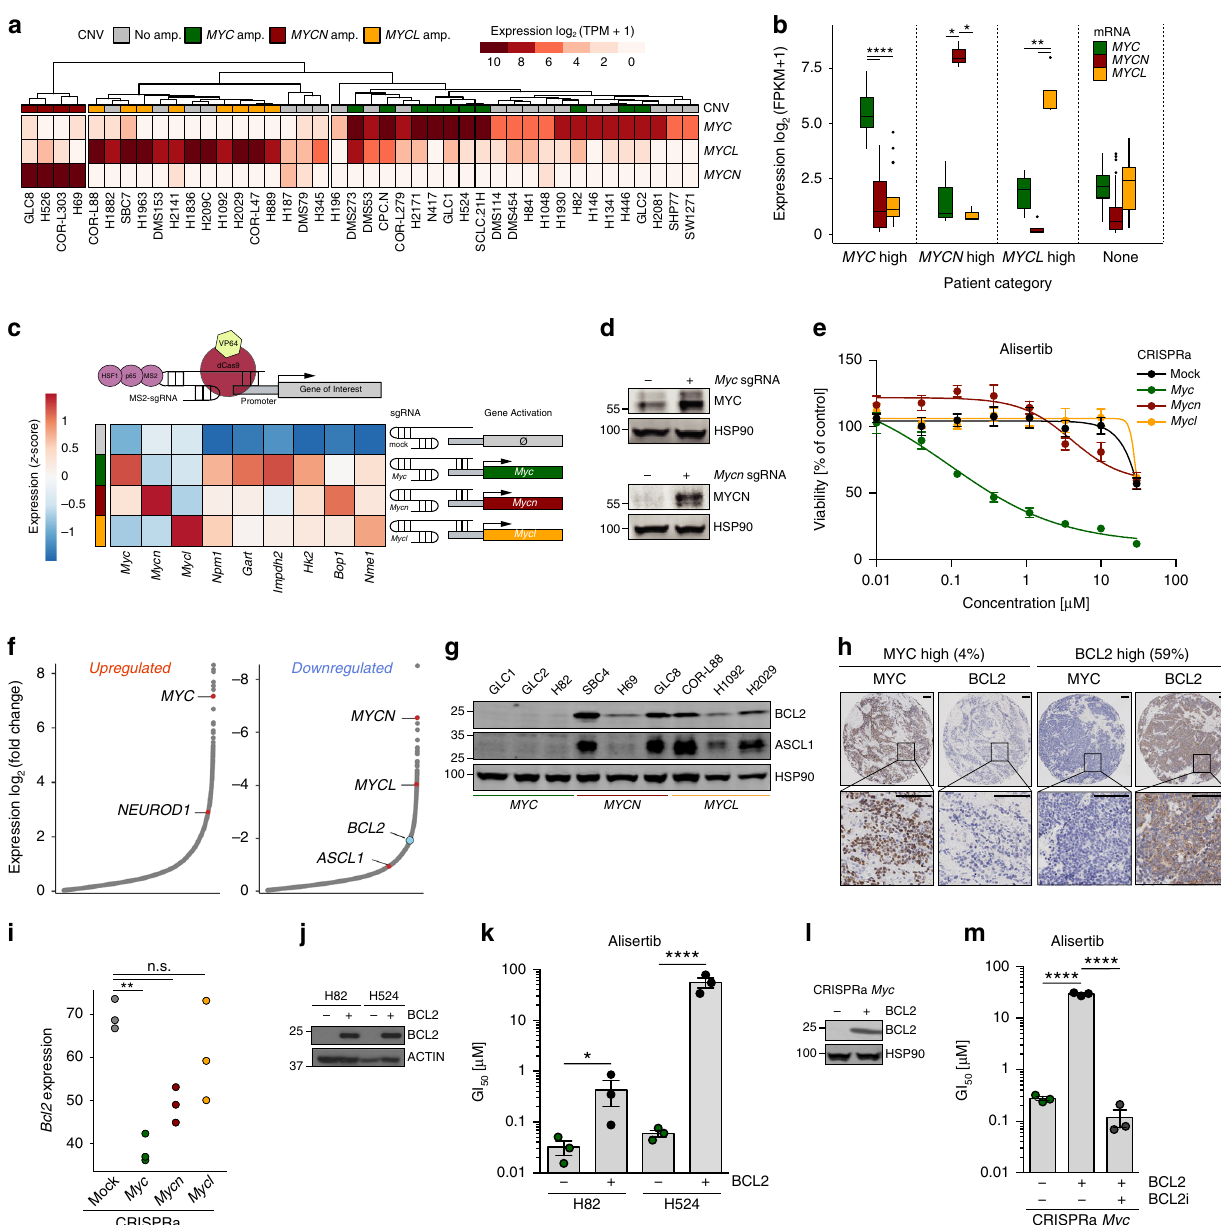
Fig. 1 MYC activation is associated with low BCL2 expression. a MYC paralog expression (TPM) and copy number variation (CNV) in human small cell lung cancer (SCLC) cell lines ( n = 42). b MYC paralog expression in SCLC patients. Center line (median), lower/upper box hinges (25th/75th percentile), whiskers extend to the most extreme value within 1.5× interquartile range (IQR) of the hinges. c CRISPRa system for transcriptional upregulation of Myc paralogs (top). Expression ( z -scores) of Myc paralogs and Myc target genes in CRISPRa cells (bottom). d Western blot showing MYC and MYCN in Myc- and Mycn -activated CRISPRa cells compared to mock control. HSP90 was used as a loading control. e Viability screening of Myc -activated CRISPRa cells treated with alisertib for 96 h ( n = 3). f Differentially upregulated and downregulated genes (sorted by log 2 fold-change) in human SCLC cell lines ( n = 42) with high MYC ( n = 22) vs. low MYC ( n = 20) expression. g Western blot of ASCL1 and BCL2 in MYC paralog-ampli fi ed human SCLC cell lines ( n = 9). HSP90 was used as a loading control. h Immunohistochemical staining of MYC and BCL2 in tumors of SCLC patients with high MYC (left) or high BCL2 (right) expression (percentage of patients in the cohort ( n = 49) with high BCL2 or MYC levels is indicated. Scale bar = 100 µ m). i Bcl2 expression (counts normalized to library size) in Myc paralog-activated CRISPRa cells. Benjamini – Hochberg-adjusted p values for Myc paralogs were obtained as contrasts of a global differential expression test. j Western blot showing BCL2 levels in MYC -ampli fi ed H82 and H524 cells ± BCL2 overexpression. HSP90 was used as a loading control. k GI 50 values of MYC -ampli fi ed H82 and H524 cells ± BCL2 overexpression treated with alisertib for 72 h ( n = 3). l Western blot of BCL2 in Myc -activated CRISPRa cells ± BCL2 overexpression. HSP90 was used as a loading control. m GI Myc -activated CRISPRa cells ± BCL2 50 values of overexpression treated with alisertib alone or in combination with 500 nM venetoclax (BCL2i; n = 3). Error bars indicate mean ± SEM. Two-tailed unpaired t tests, **** p < 0.0001, ** p < 0.01, * p < 0.05. Source data are provided as a Source Data fi